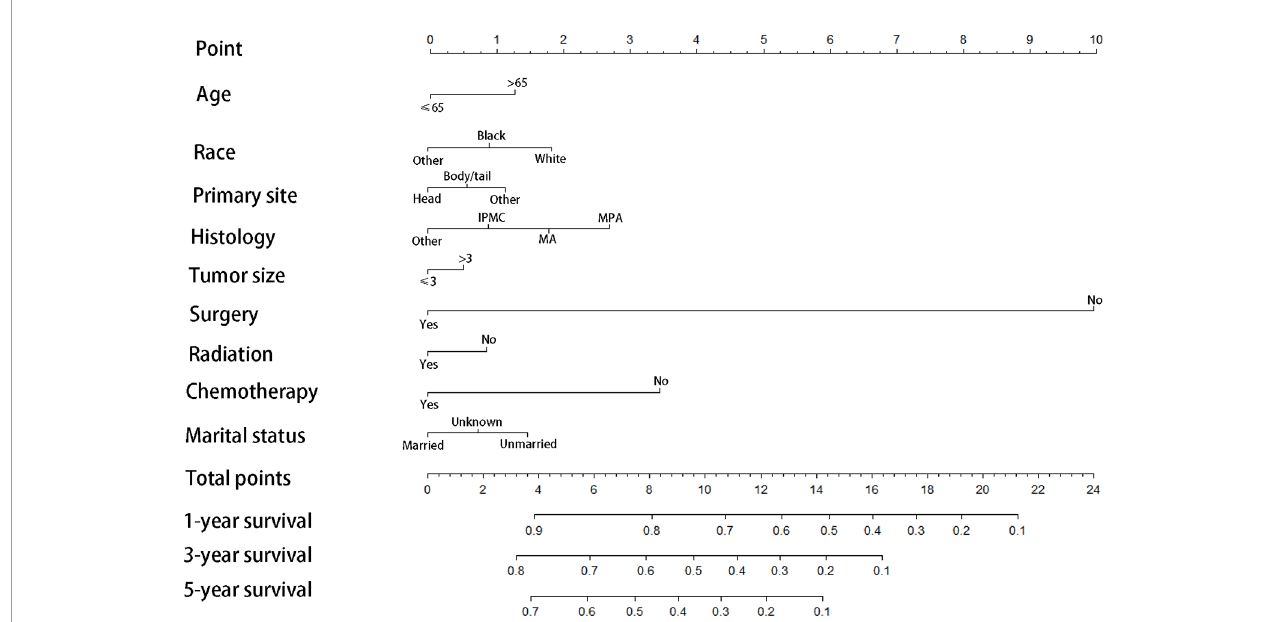
FIGURE 3 | Prognostic nomogram predicting 1-, 3-, and 5-year cancer-speci fi c survival probability for patients with IPMN with associated invasive carcinoma, IPMC, Intraductal papillary-mucinous carcinoma; MA, mucinous adenocarcinoma; MPA,mucin-producing